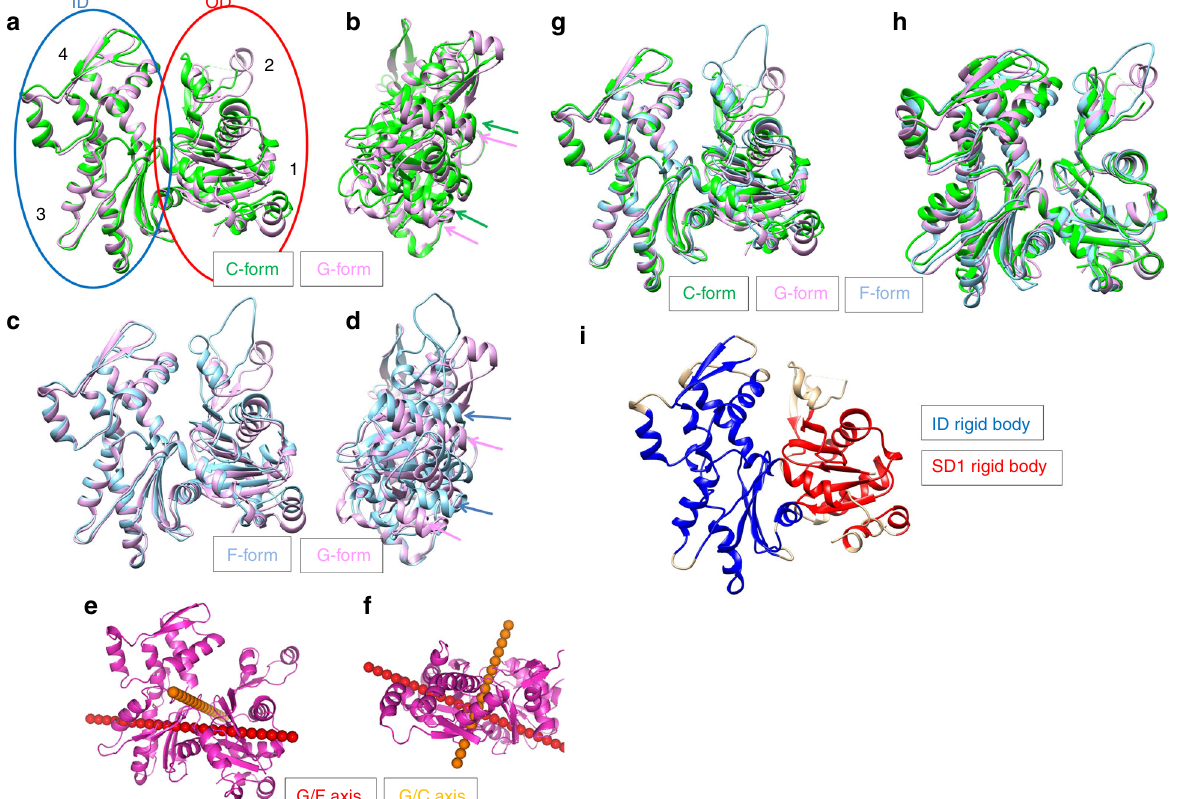
Fig. 2 Actin structural changes in co fi lactin. a Comparison between the G-actin (1J6Z, magenta, G-form) and actin subunit in co fi lactin (green, C-form). The actin molecule is considered to have two domains, the inner domain (ID, blue ellipse) and outer domain (OD, red ellipse). Each domain is divided into two subdomains, OD into subdomains 1 and 2, and ID into 3 and 4. Each subdomain is indicated by a number (1, 2, 3 and 4). The structures are aligned through superimposition of the IDs. b Side view of a , rotated by 90°. Green and magenta arrows represent the orientation of two α -helices (79 – 95, 359 – 365) of the C-form and G-form, respectively. The two α -helices shift but do not tilt in the structural change. c Comparison between the G-form and F- form (5JLF, cyan). The structures are aligned through superimposition of the IDs. d Side view of c . Blue and magenta arrows represent the orientation of the two α -helices (79 – 95, 359 – 365) of the F-form and G-form, respectively. The two α -helices tilt in the structural change 23 . e Rotation axes. G/F axis (red) and G/C axis (orange) are superposed on the G-form (1J6Z, magenta). f Top view of e . g The G-form (1J6Z, magenta), F-form (5JLF, cyan) and C-form (green) are superposed by aligning the rigid bodies of the ID (blue in Fig. 2i). h The three forms are superposed by aligning the rigid bodies of SD1 (red in Fig. 2i) as in G. i Rigid bodies in the ID and SD1 are shown in blue and red,